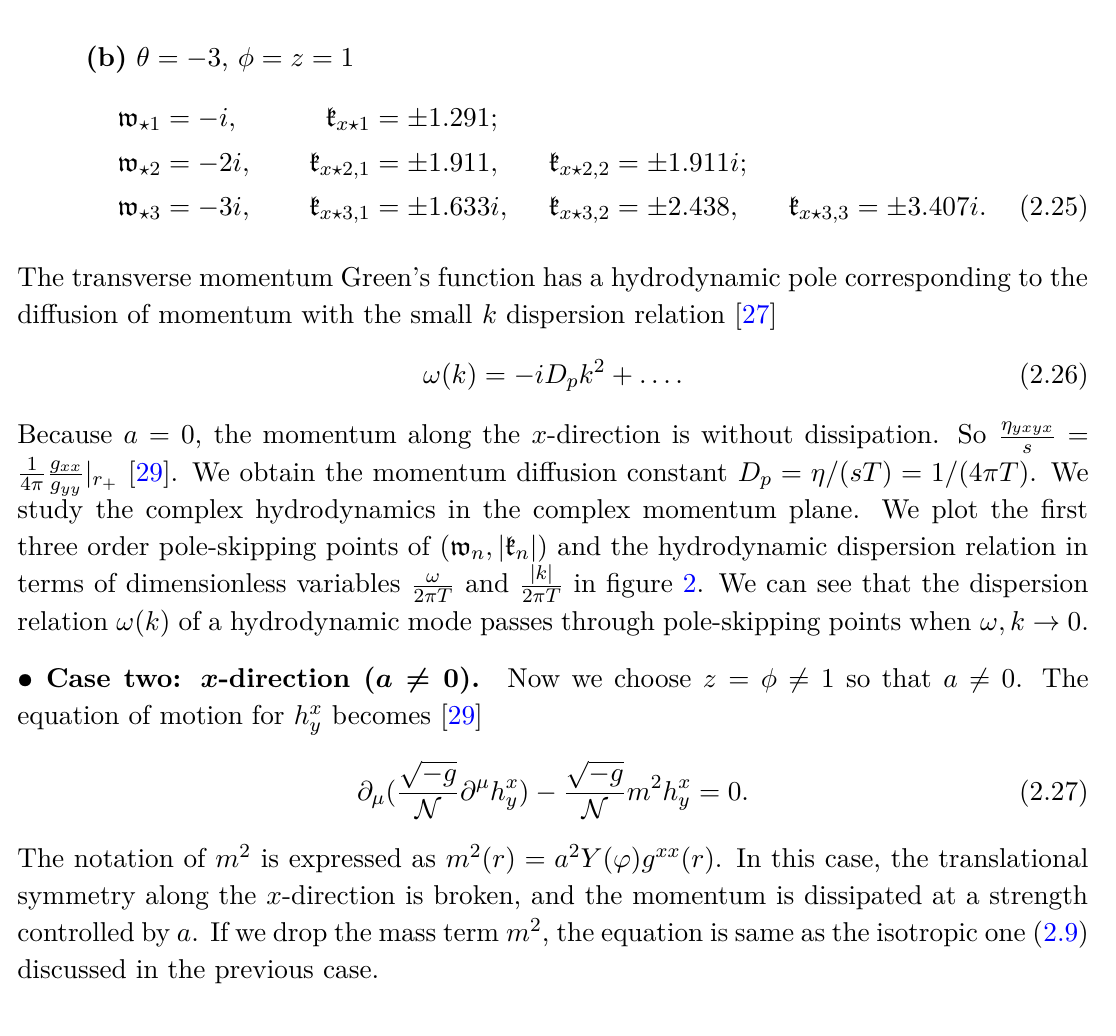
Figure 2 . Solid lines show the diffusive hydrodynamic dispersion relation (2.26). The intersections of the dashed lines correspond to the first three order pole-skipping points of tensor mode h y the x -direction in the anisotropic system near Lifshitz points when a = 0 . Blue dots and red triangles show the curve fitting of pole-skipping points of the data which we set (a) z = φ = 1 , θ = 0 ; (b) z = φ = 1 , θ = − 3